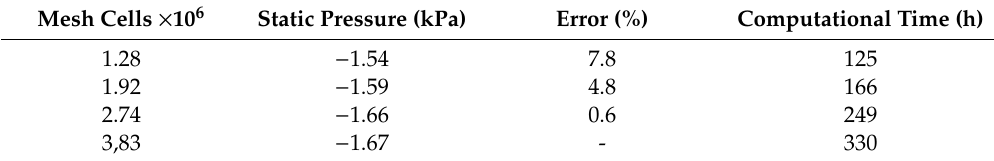
Table 2. Sensitivity analysis of computation